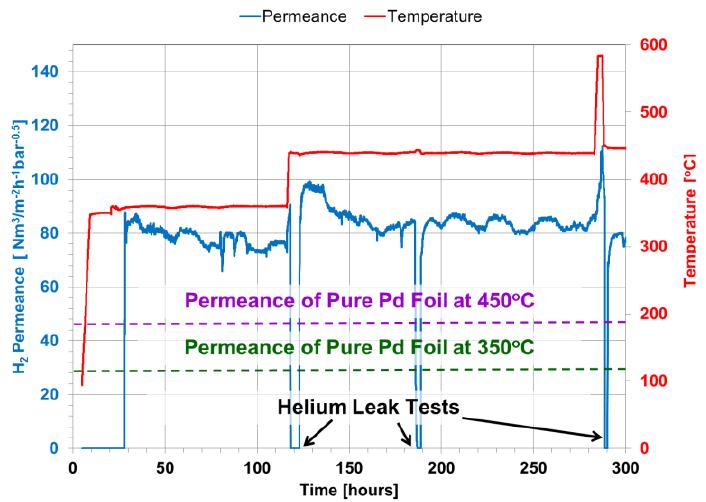
Figure 3. Hydrogen permeance, He leak tests at 350, 450 and activation at 585 °C at different elapsed times.